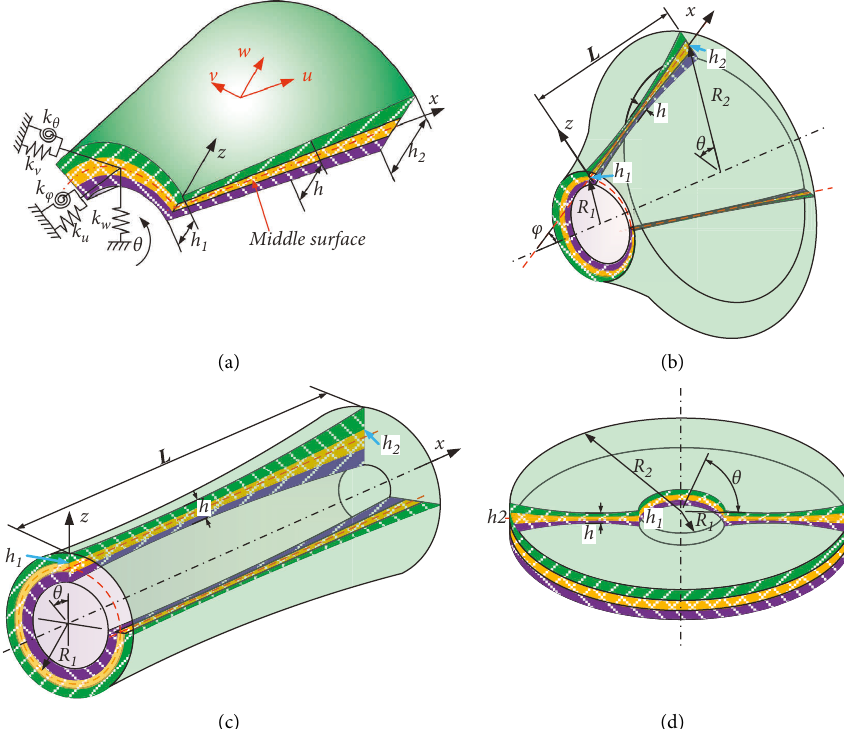
Figure 1: The diagram of the laminated composite structure with variable thickness, (a) cross-section view and boundary condition, (b) conical shell, (c) cylindrical shell, and (d) annular plate.